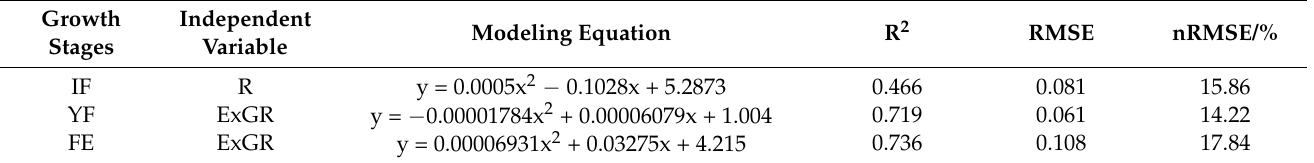
Table 5. Comparison of single-factor model for kiwifruit LAI in each growth